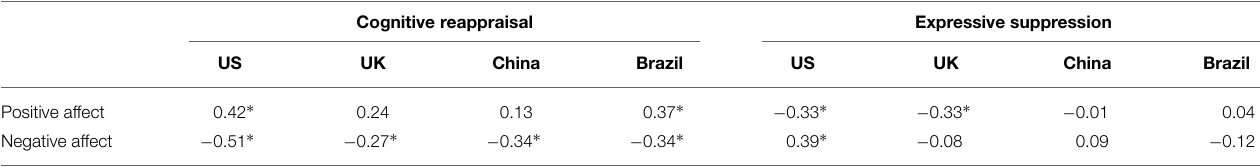
TABLE 2 | Correlations between ERQ subscales and affect across samples from different